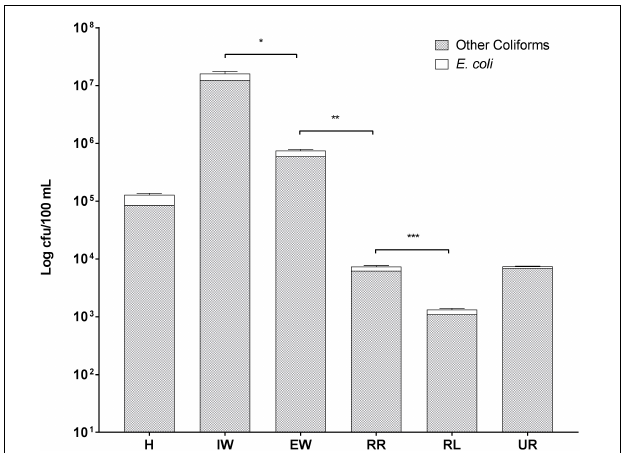
FIGURE 2 | Levels of E. coli and other coliform bacteria in wastewaters and recipient environmental waters in Örebro Sweden. Symbols in the figure represent the following: H, hospital wastewater; IW, incoming sewage water from the wastewater treatment plant; EW, effluent wastewater from the wastewater treatment plant; UR, surface water from Svartån river upstream of Örebro city; RR, surface water from Svartån river water downstream of wastewater treatment plant; and RL, surface water from Hjälmaren lake downstream of wastewater treatment plant. Statistical significance is shown by ∗ for P ≤ 0.05, ∗∗ for P ≤ 0.01, and ∗∗∗ for P ≤ 0.001 as determined by Student’s t- test. Error bars represent the standard deviation of three biological replicates ( n =